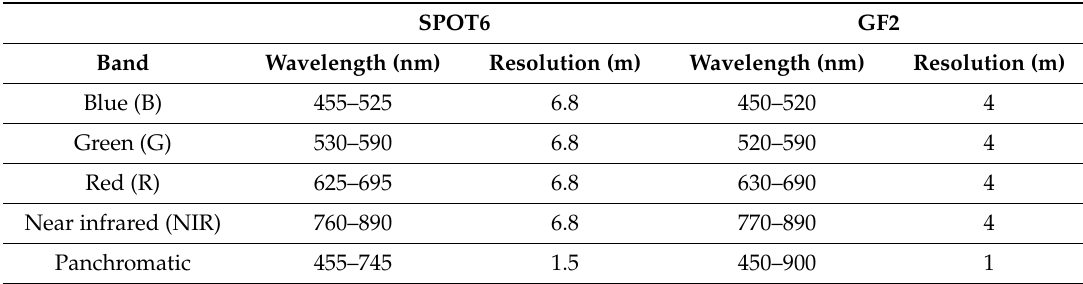
Table 1. The spectral bands and resolution of GF2 and SPOT6.